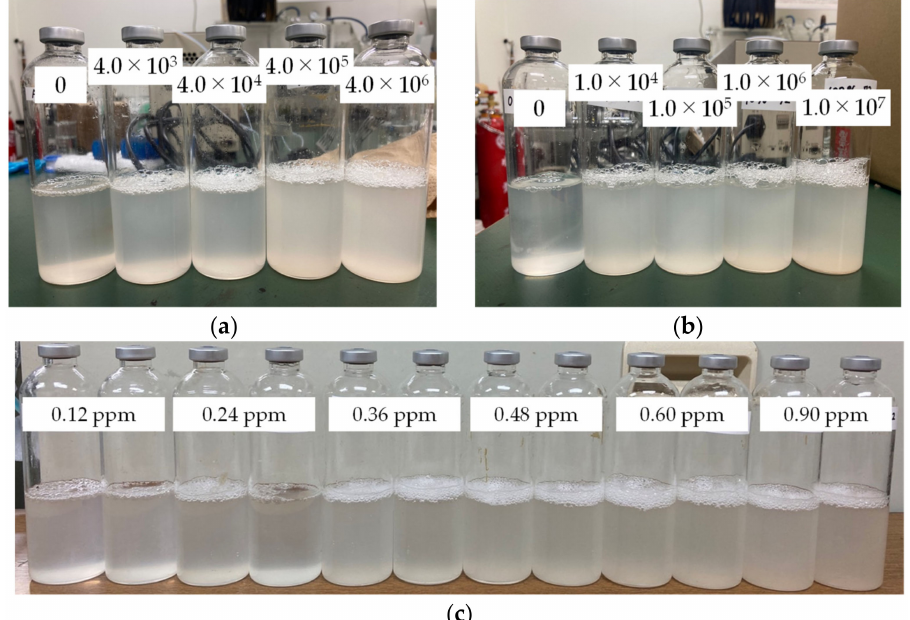
Figure 3. The culture solutions in which P. aeruginosa was cultivated in media for 72 h with different numbers of nanobubbles and concentrations of ferrous sulfate: ( a ) the culture solutions containing different numbers of oxygen nanobubbles; ( b ) the culture solutions containing different numbers of carbon dioxide nanobubbles; ( c ) the culture solutions containing different concentrations of ferrous